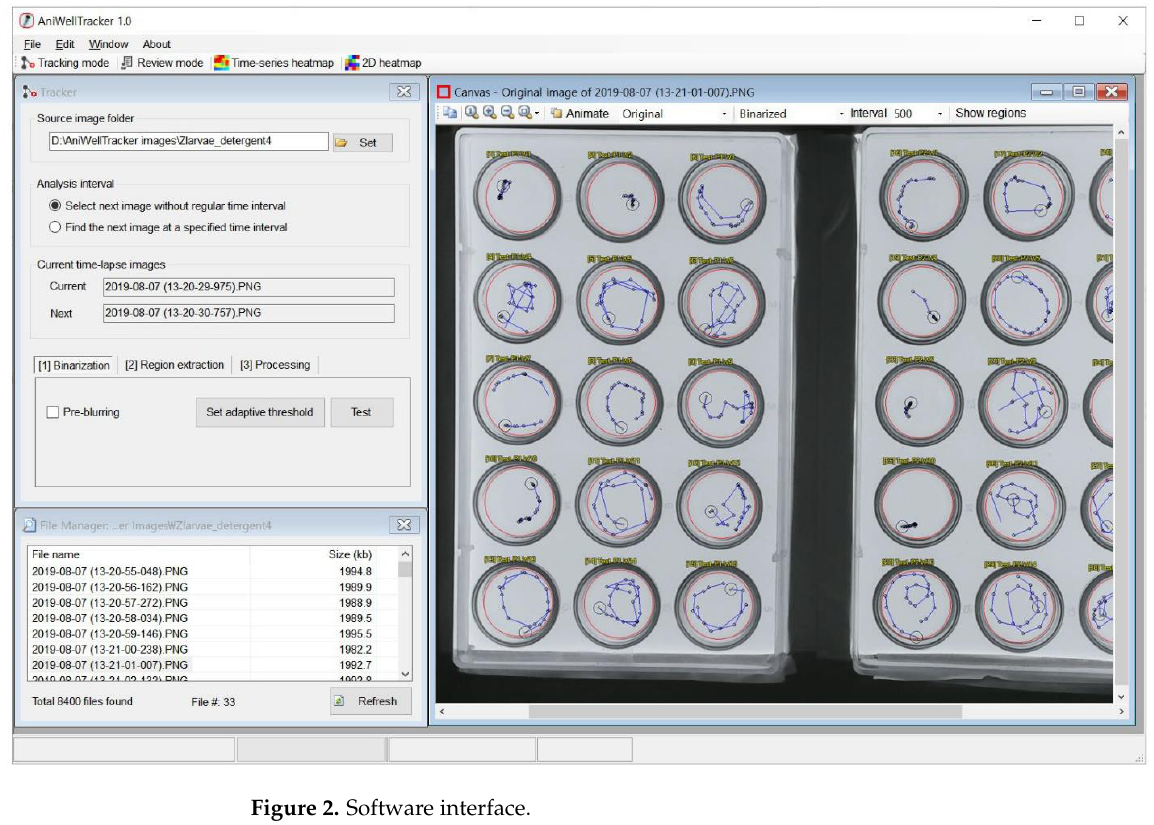
Figure 2. Software interface.